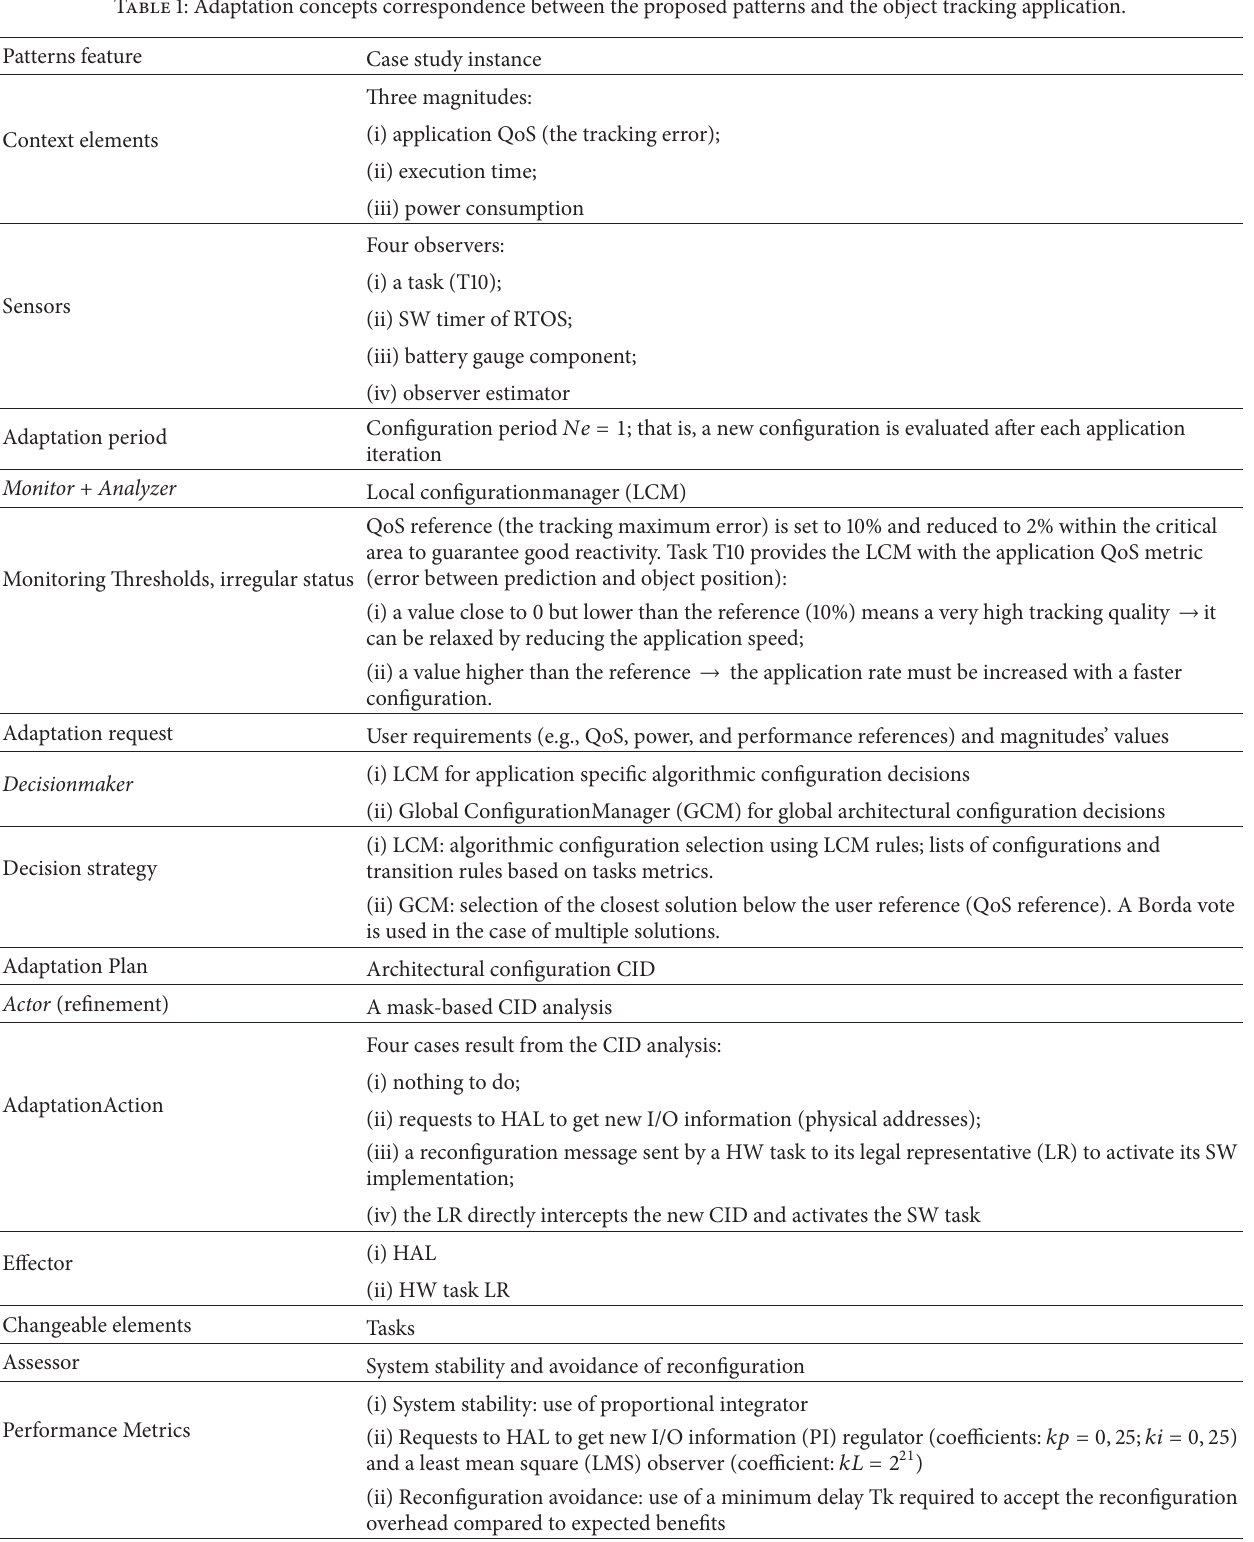
Table 1: Adaptation concepts correspondence between the proposed patterns and the object tracking application. Patterns